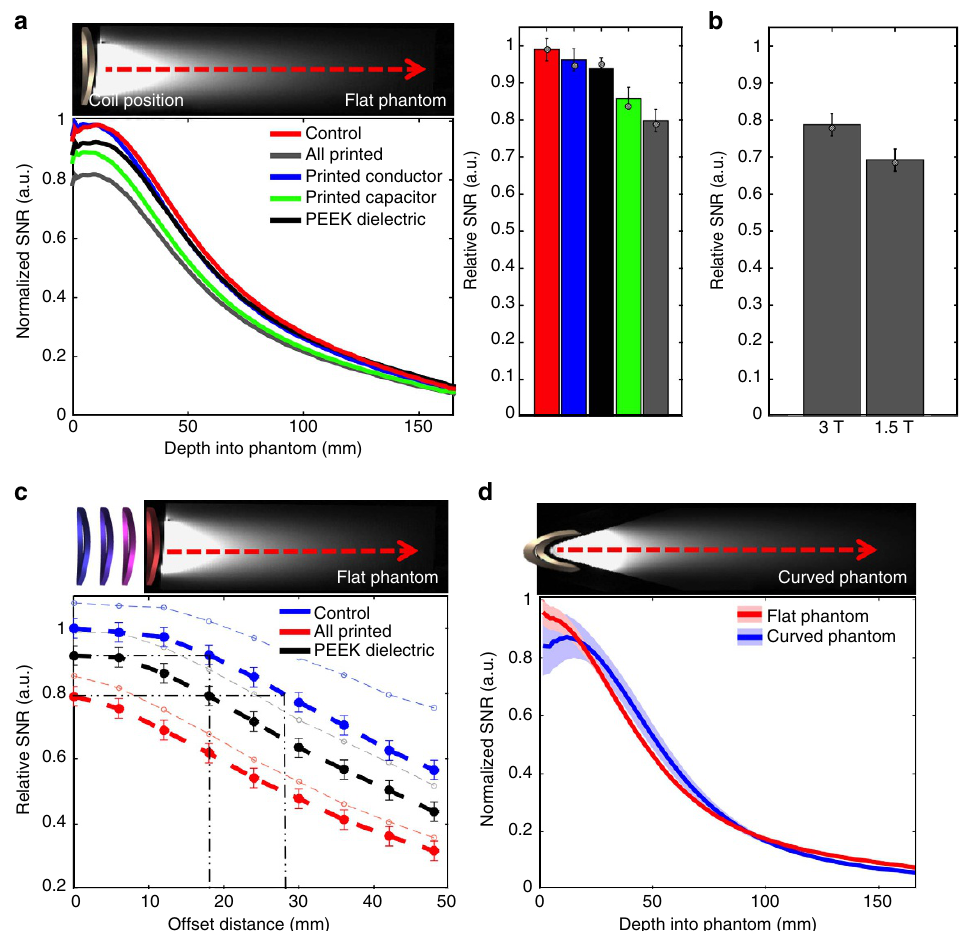
Figure 3 | 1.5- and 3-T scanner receive coil SNR characterization. ( a ) Normalized SNR versus depth into the phantom for coils fabricated with different permutations of printed components at 3T, with schematic showing coil position 3mm away from conductive fluid. Bar graph summarizes trends shown in relative SNR for each coil type. Dot on bar graph shows predicted SNR extracted from bench top quality factor measurements. ( b ) Relative measured (bars) and bench top-predicted (dots) image SNR of printed coils at 1.5 and 3T. ( c ) Relative SNR for control and printed coils versus increasing coil offsets from the top surface of the phantom. Black dashed-dotted line highlights the position offset where the control coil shows equal SNR to the printed coils when the printed one has no offset from the top surface of the phantom. Light thin lines represent calculated best case performance when preamplifiers are added to the coil. Error bars show standard deviation. ( d ) Average normalized SNR profile for printed coils flexed around the surface of a curved saltwater phantom (blue) and placed on a flat phantom (red) at 3T. Wide coloured bands indicate the s.d. across several